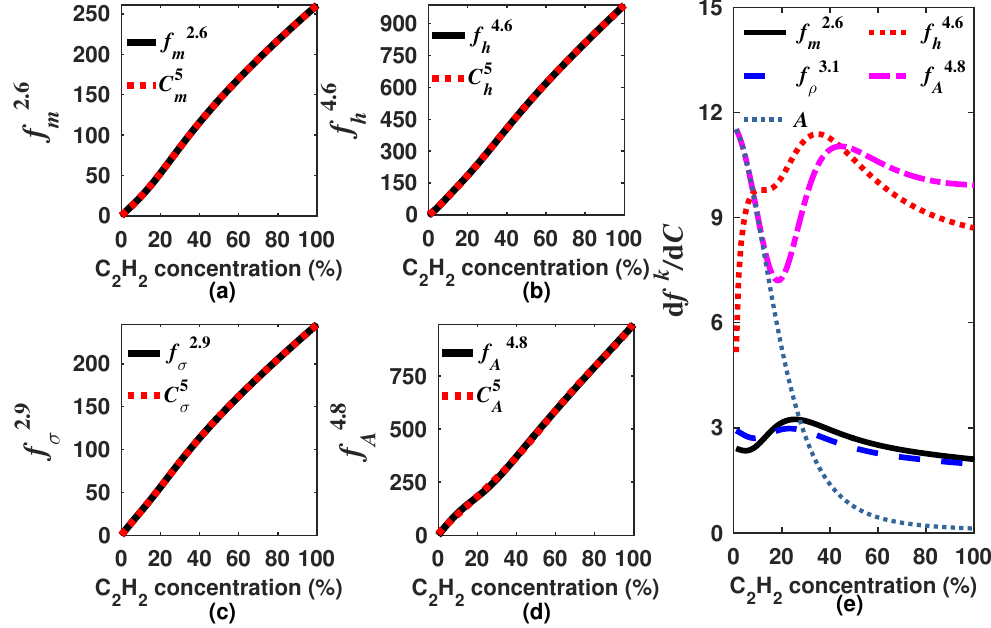
. ; ( c ) f k σ and ( d ) f k for our experimental A h